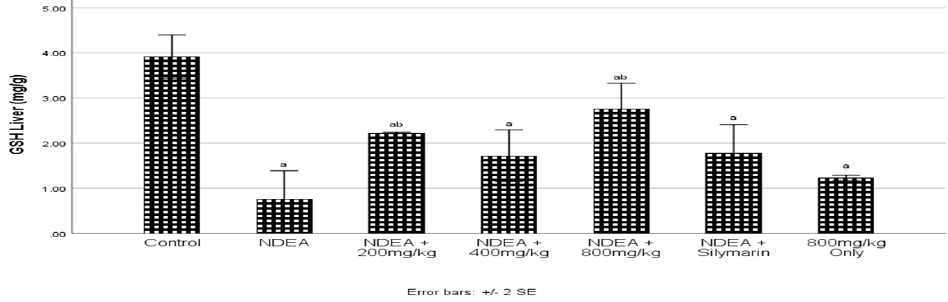
Figure 6. Effect of Cajanus cajan on reduced glutathione. Values are expressed as mean ± SEM; a Values differ significantly from the control group; b Values differ significantly from the NDEA-treated group.